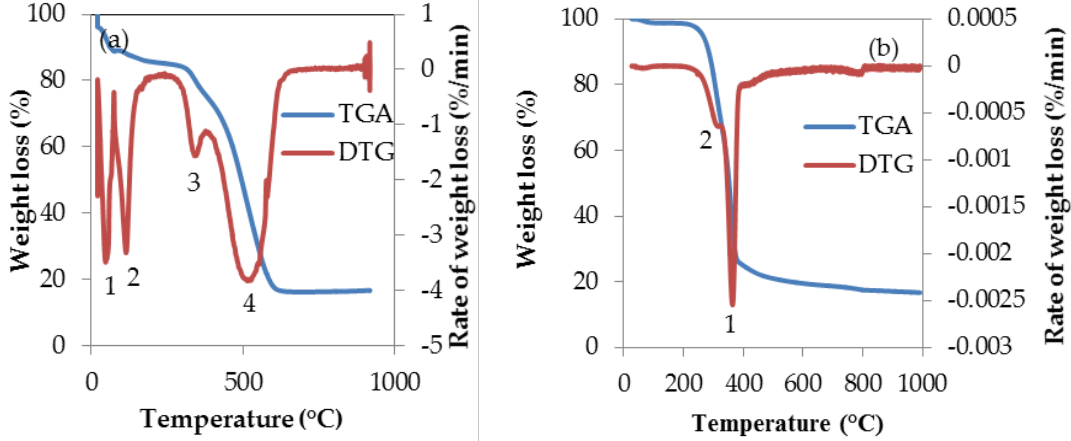
Figure 5. TGA and DTG plots of SCB obtained at 10 °C·min −1 heating rate: ( a ) torrefied SCB; ( b ) untorrefied SCB.